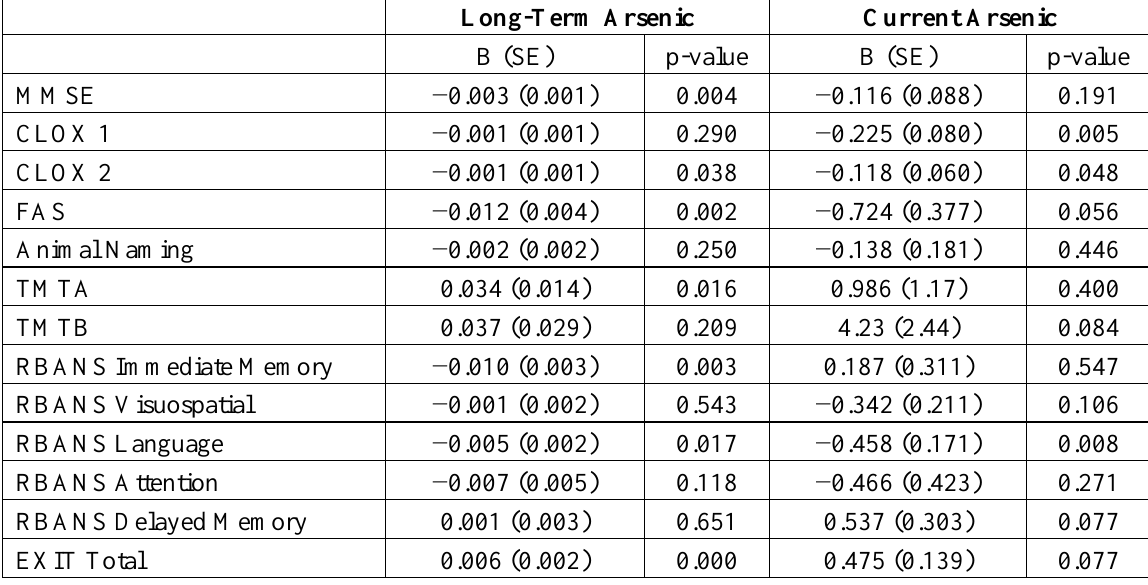
Table 3. Arsenic levels impact on neuropsychological